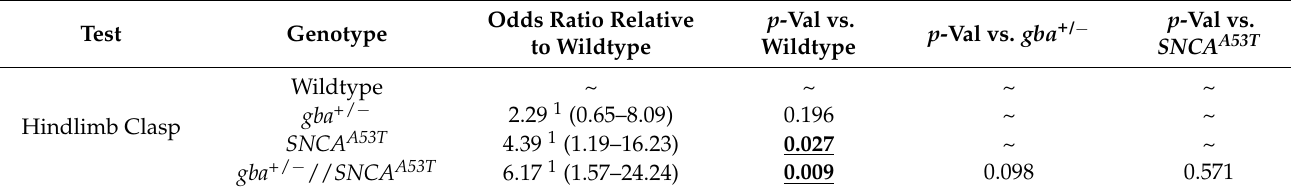
Table 2. Results of the backwards ordinal mixed-model regression of hindlimb clasp scores. Odds ratio values indicate the chance that a given mouse genotype will have an abnormal HLC score relative to wildtype mice. Values in parentheses represents the 95% confidence interval. p -values comparing incidence of abnormal HLC score between genotypes are also provided. Significant p -values ( p < 0.05) are underlined and in